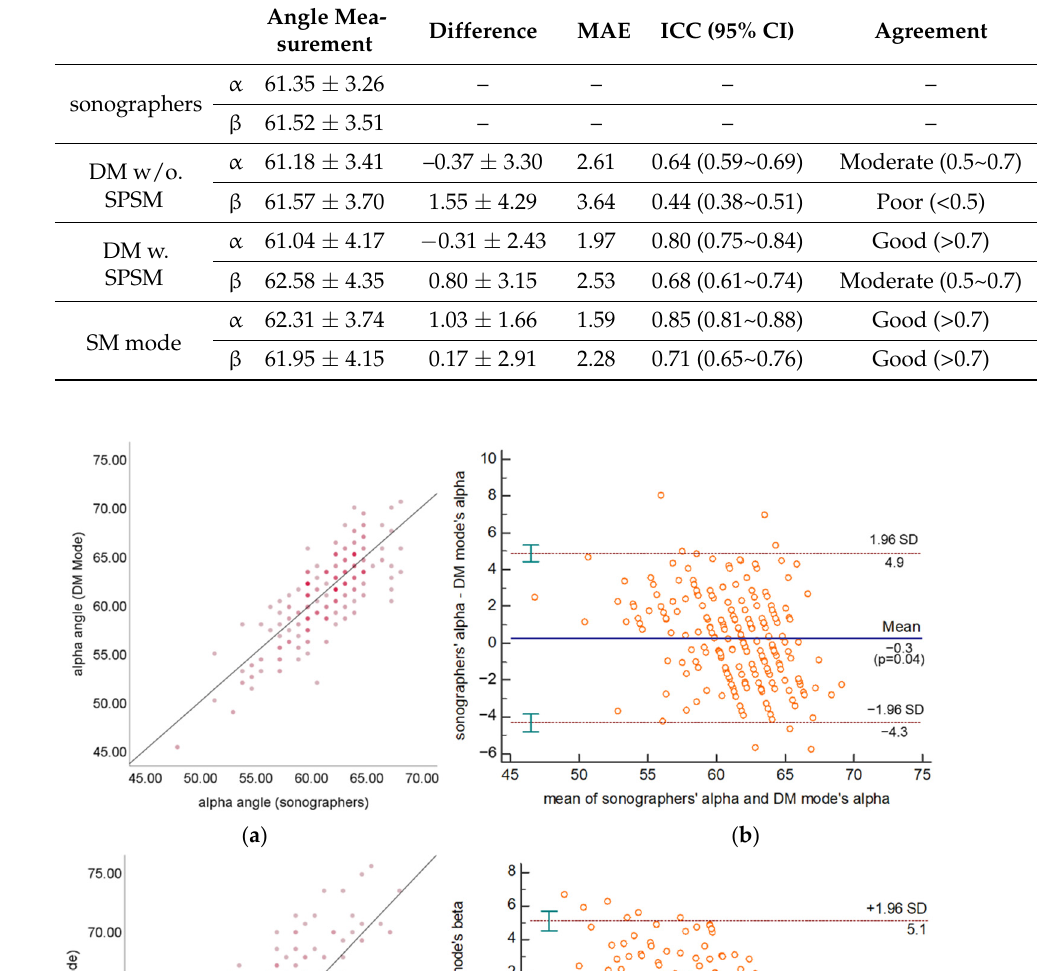
Table 3. Comparison of angle measurement between DM w/o. SPSM, DM w. SPSM, SM mode, and sonographers.